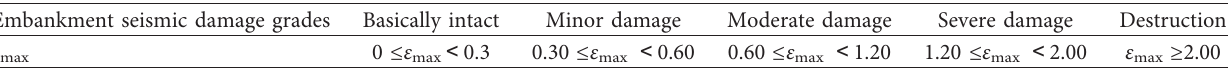
Table 2: Boundaries of ε max among the embankment seismic damage